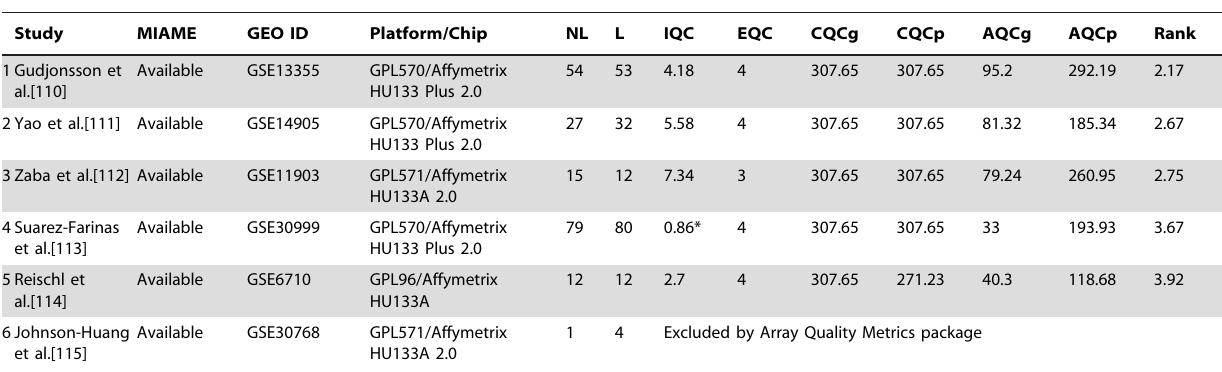
Table 1. Study information and QC measure